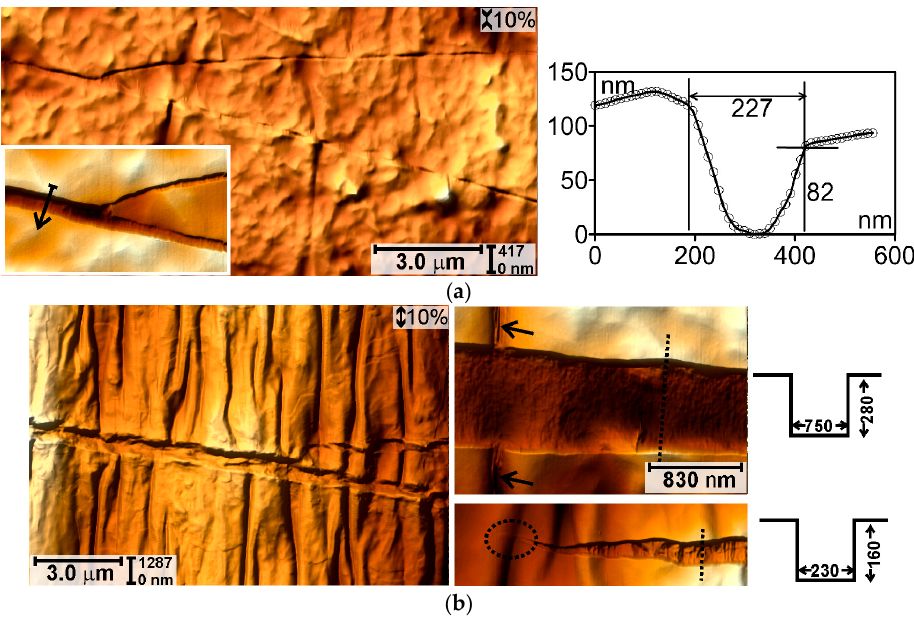
Figure 3. AFM images of PU after the PIII 1-16 and fatigue loading to 10%: open cracks are visible in the unloaded ( a ) and stretched ( b ) states. Longitudinal folds appear on the stretched surface. The width and depth (in nm) of the cracks are indicated. The arrows in ( b ) indicate the bending of folds and the circle marks the crack tip stopped by the fold.